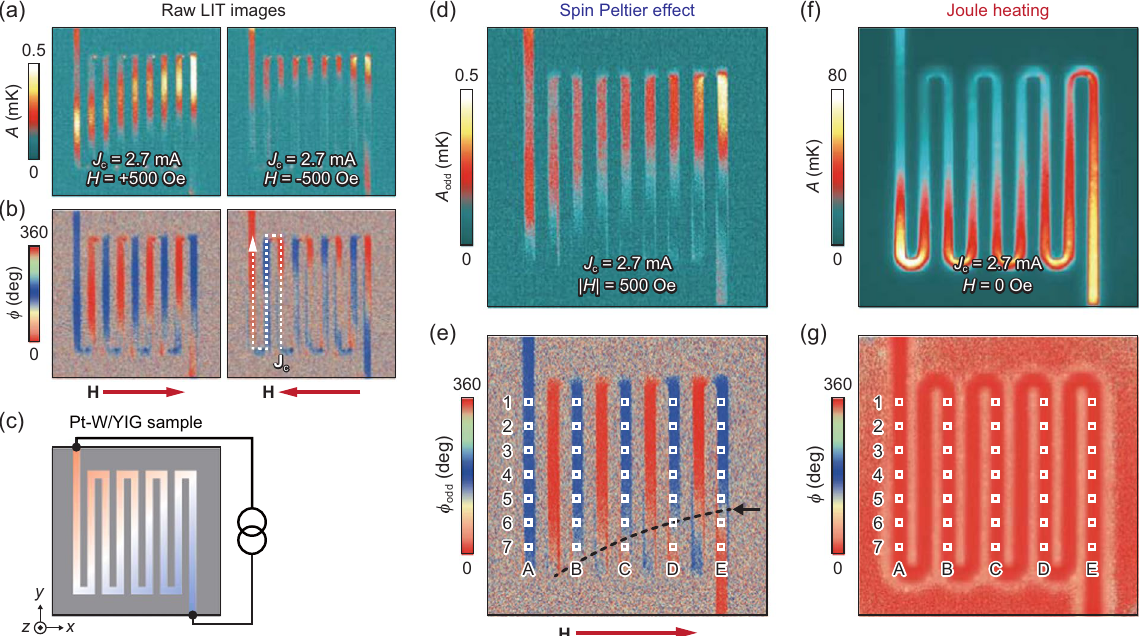
Figure 3. LIT images. ( a , b ) Raw amplitude A ( a ) and phase φ ( b ) images for the Pt-W/YIG sample at J c = 2.7 mA and f = 25.0 Hz, measured in the SPE condition (see Fig. 1(b)). The left and right images were measured at the magnetic fields of H = + 500 Oe and − 500 Oe, respectively. ( c ) Schematic illustration of the Pt-W/YIG sample from a top view. ( d , e ) A odd ( d ) and φ odd ( e ) images for the Pt-W/YIG sample. The A odd and = − 500 Oe from those at H = + 500 Oe and φ odd images are obtained by subtracting the raw LIT images at H dividing the subtracted images by 2 (see the definition in the main text). ( f , g ) A ( f ) and φ ( g ) images for the Pt-W/YIG sample at J c = 2.7 mA, f = 25.0 Hz, and H = 0 Oe, measured in the Joule-heating condition (see Fig. 1(c)).